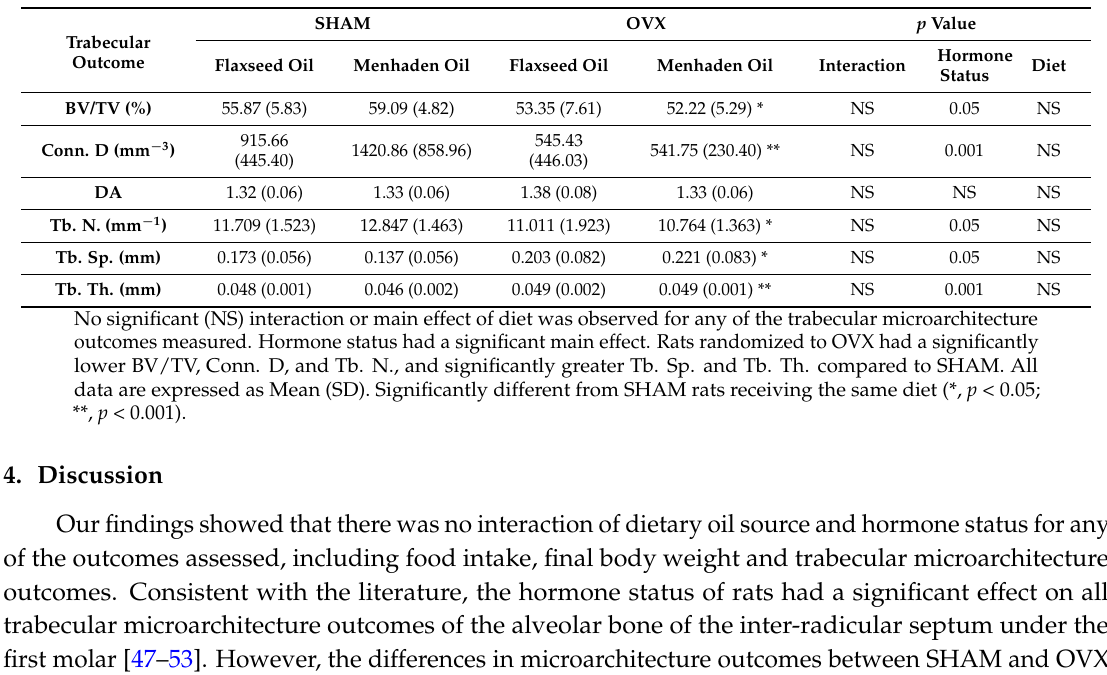
Table 3. Trabecular microarchitecture outcomes of the inter-radicular cavity below the first molar of the mandible in SHAM and OVX